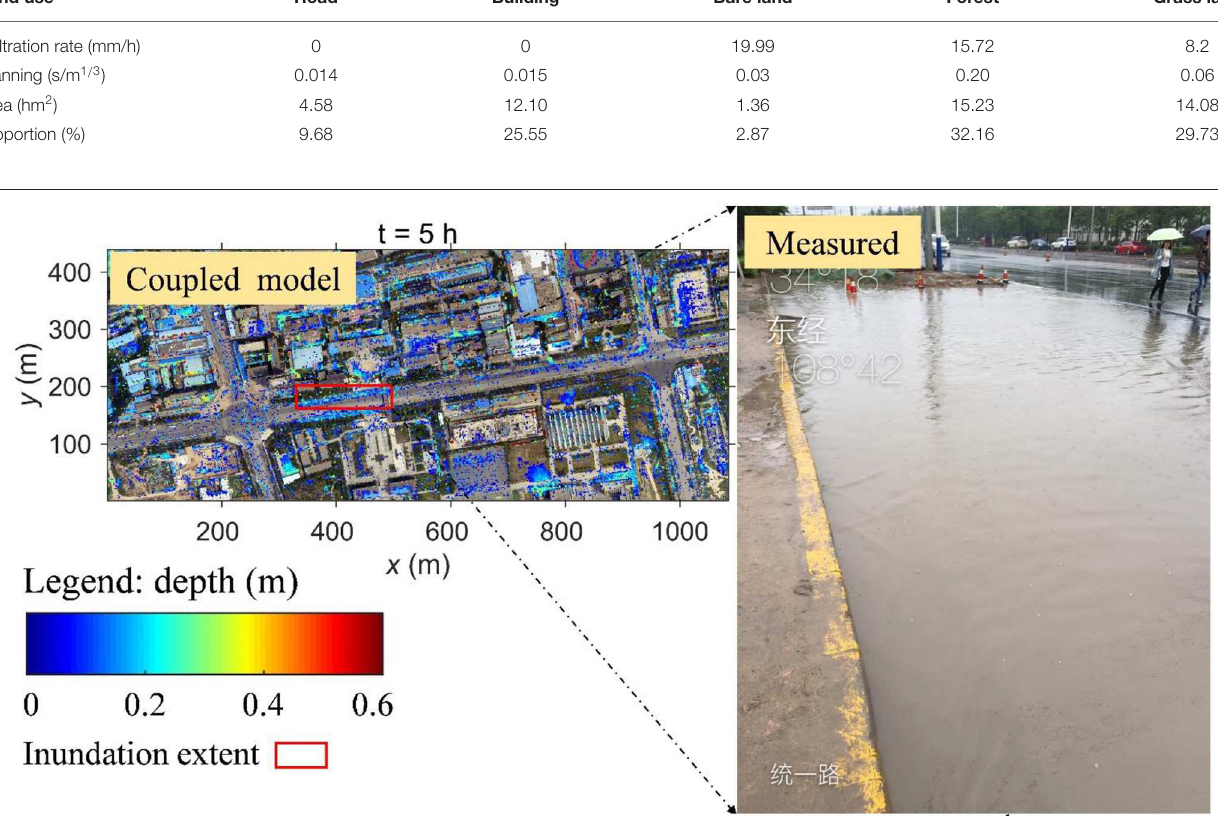
infiltrometers, which consist of open inner and outer